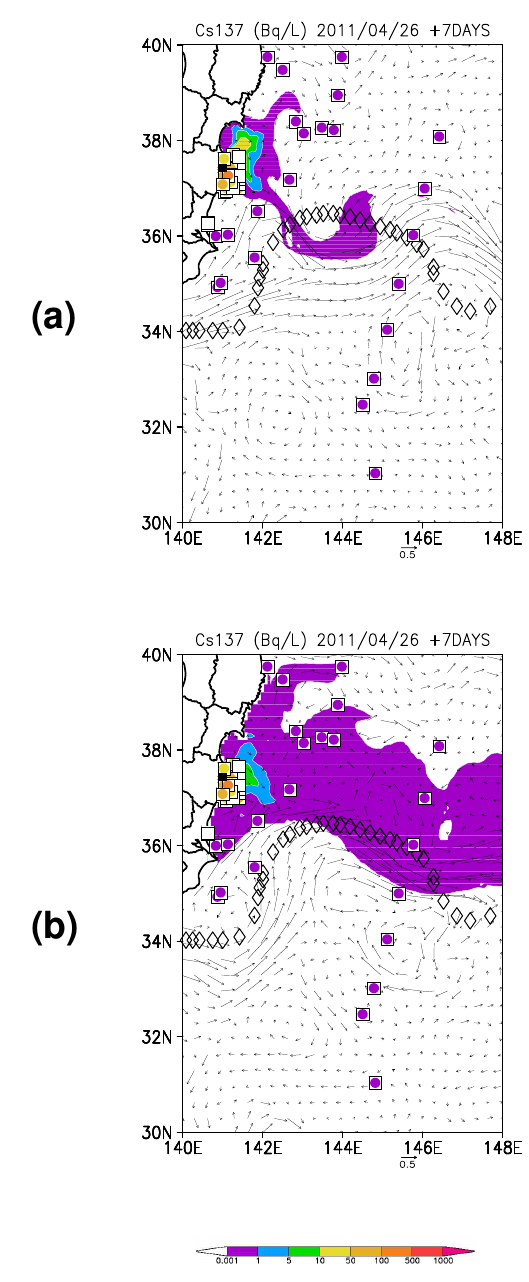
Fig. 8. (a) As in Fig. 5f, except for showing a wider region, and with open diamonds indicating the position of the Kuroshio Extension front provided by Japan Coast Guard. (b) As in (a) , except for the JCOPE2 first-guess